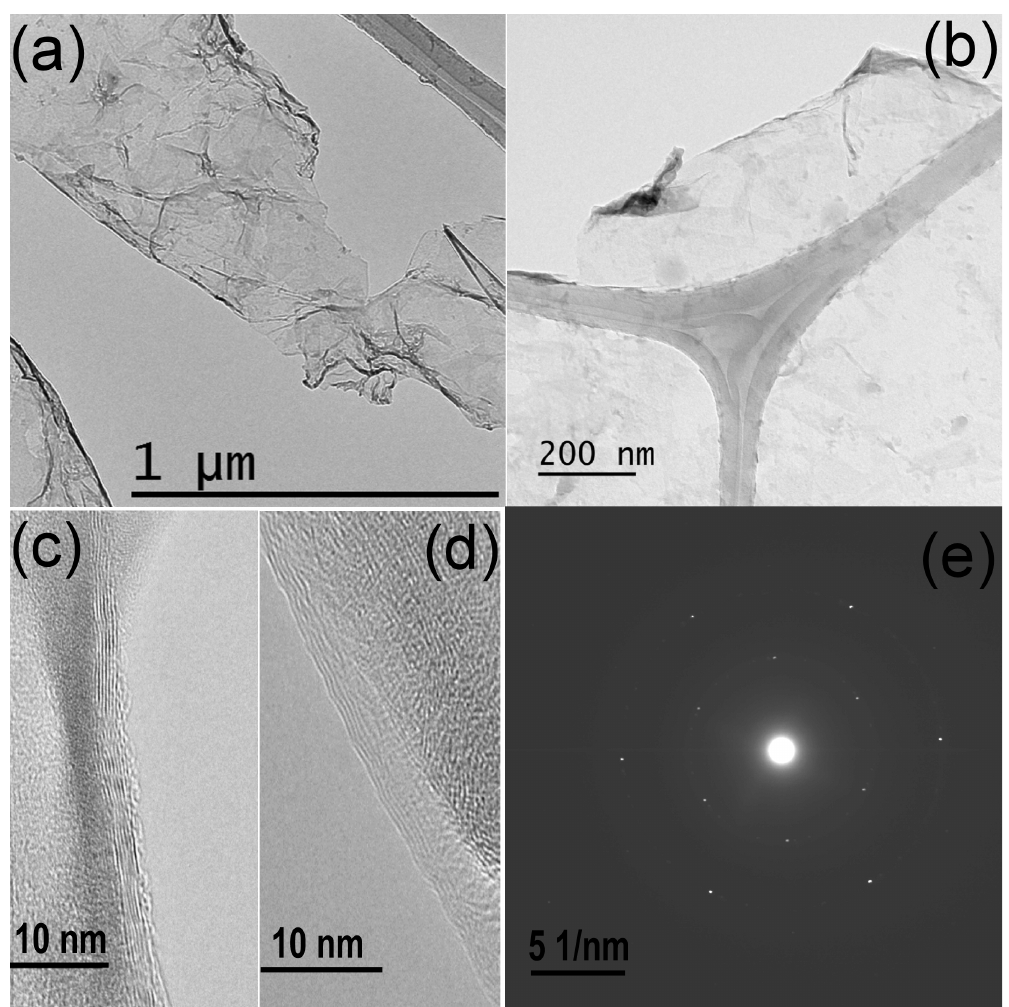
Figure 1. TEM images of large area and continuous graphene films ( a , b ). High-resolution TEM images of the edges of synthesized graphene films ( c , d ). Hexagonal selected area electron diffraction (SAED) pattern of the graphene films ( e